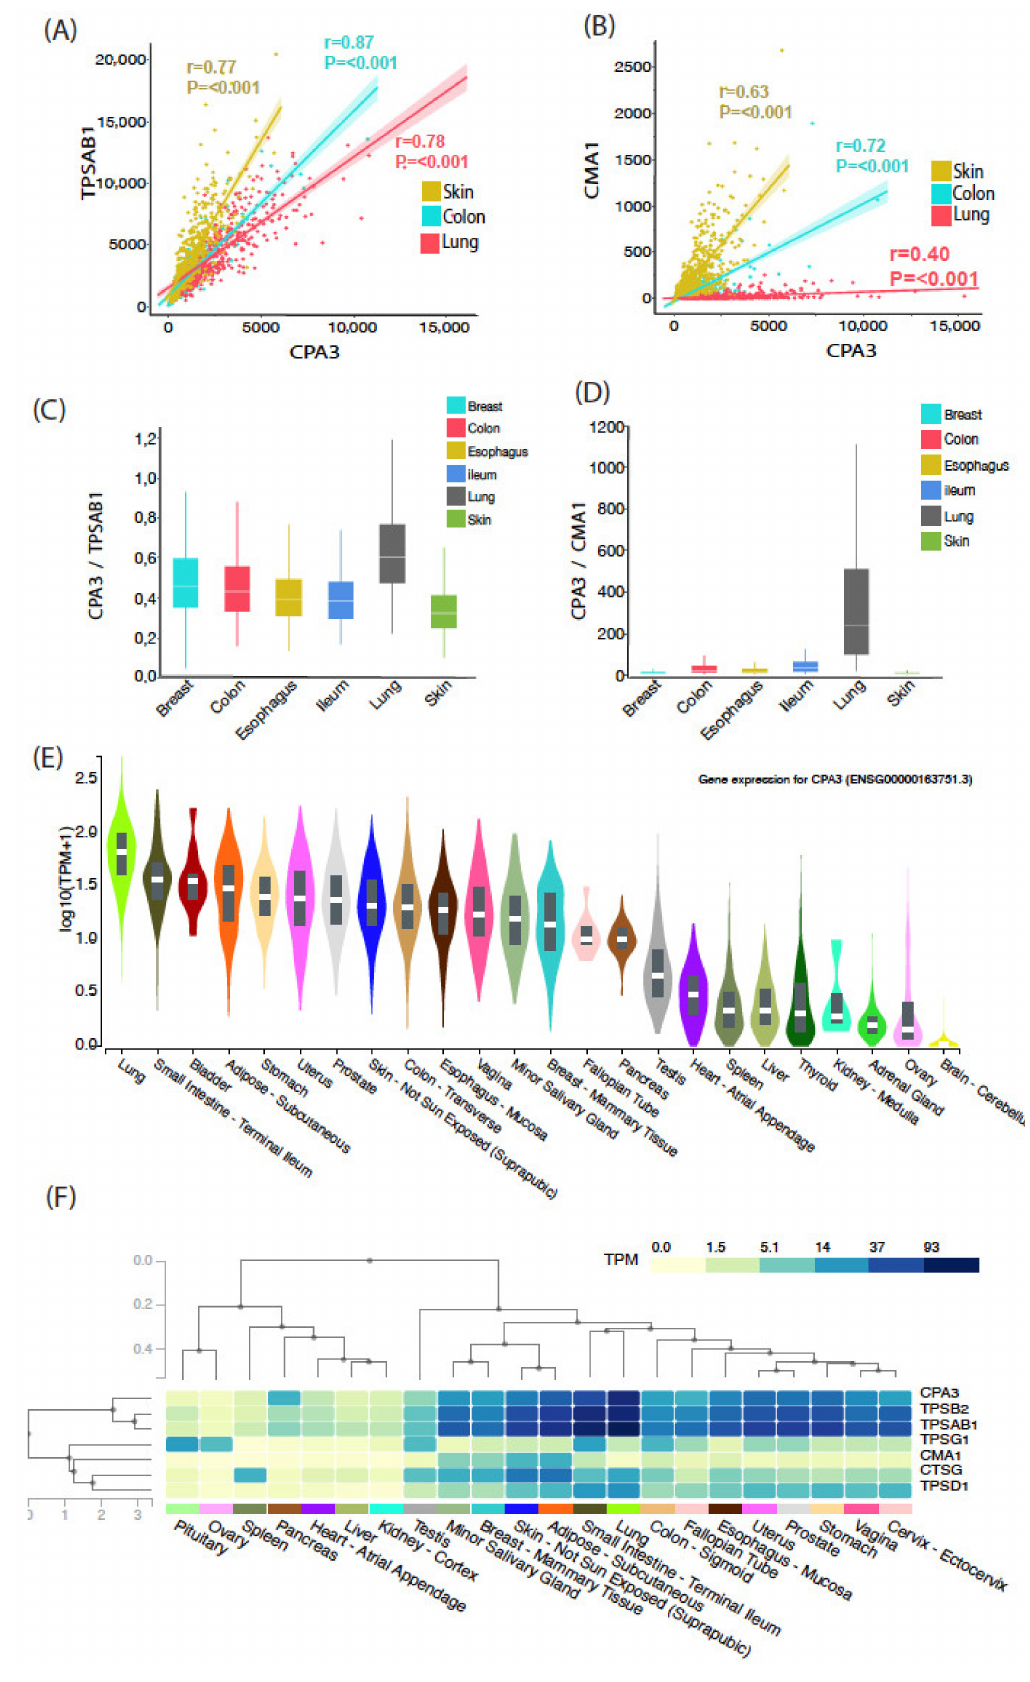
Figure 6. Analysis of tryptase, chymase and CPA3 mRNA expression profile from normalized Gtex gene expression